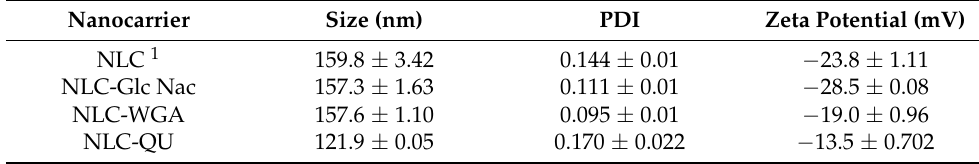
Table 2. Results of size, PDI, and zeta potential of the formulations produced by HPH when 50% of modified surfactants were added to the system with and without the addition of the WGA protein measured by